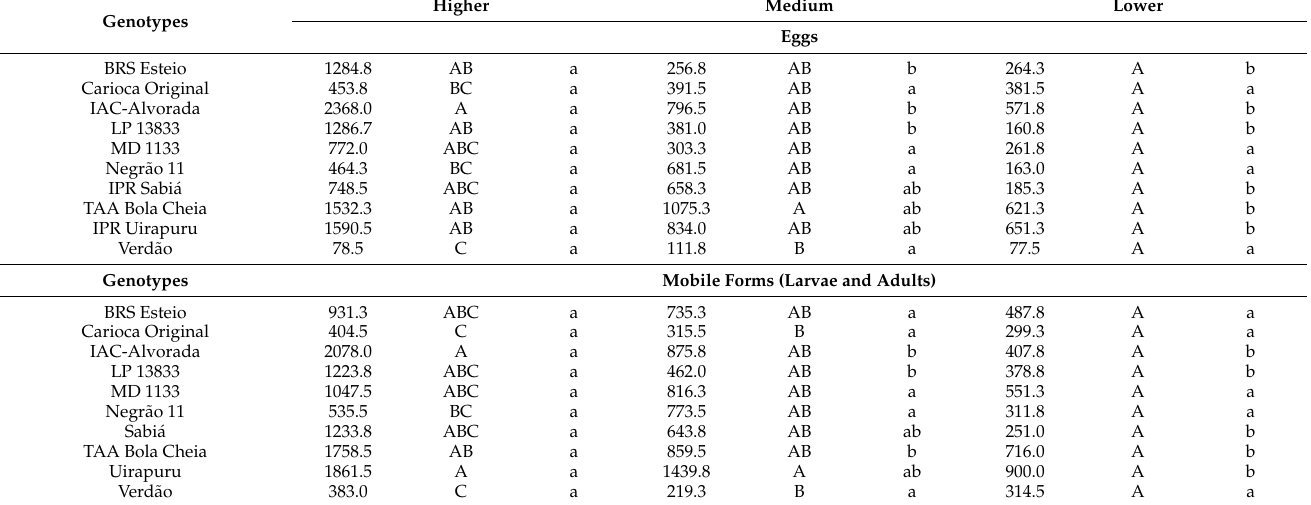
Table 4. Number of eggs and mobile forms (larvae + adults) ( n = 4) of Polyphagotarsonemus latus on leaves and pods in the higher, medium and lower third of plants of common bean ( Phaseolus vulgaris ) genotypes, 15 days after infestation. Londrina-PR, 2021. Higher Medium Lower Genotypes Eggs BRS Esteio